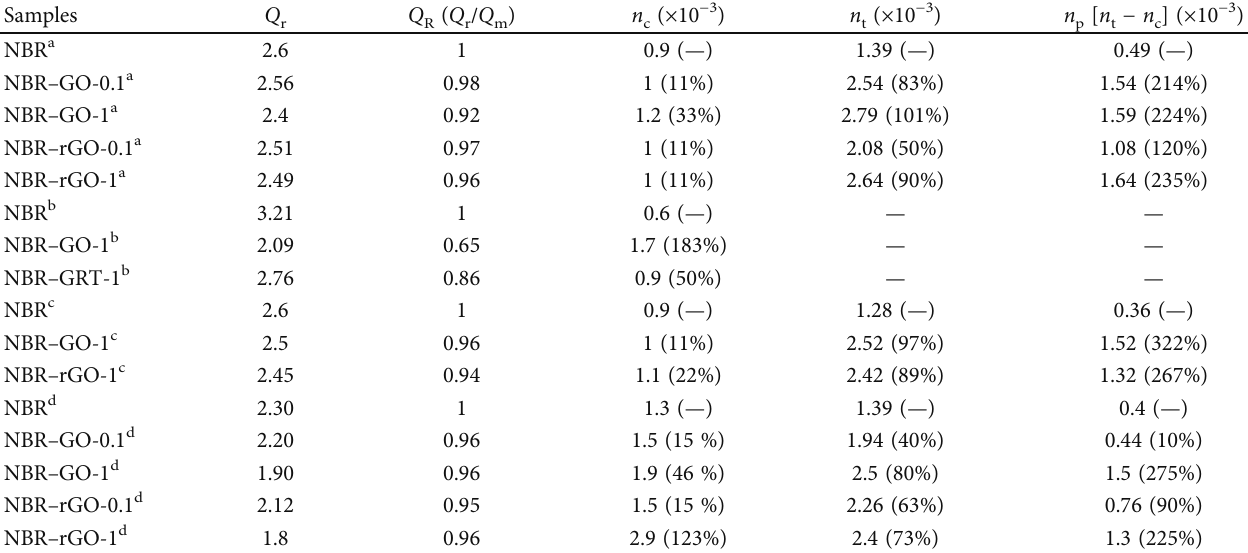
Table 5: Swelling and crosslinking density of samples.